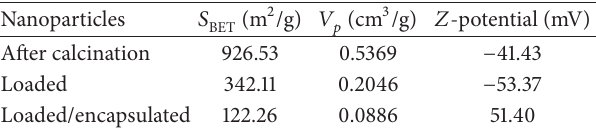
Table 1: BET/BJH and 𝑍 -potential characterization